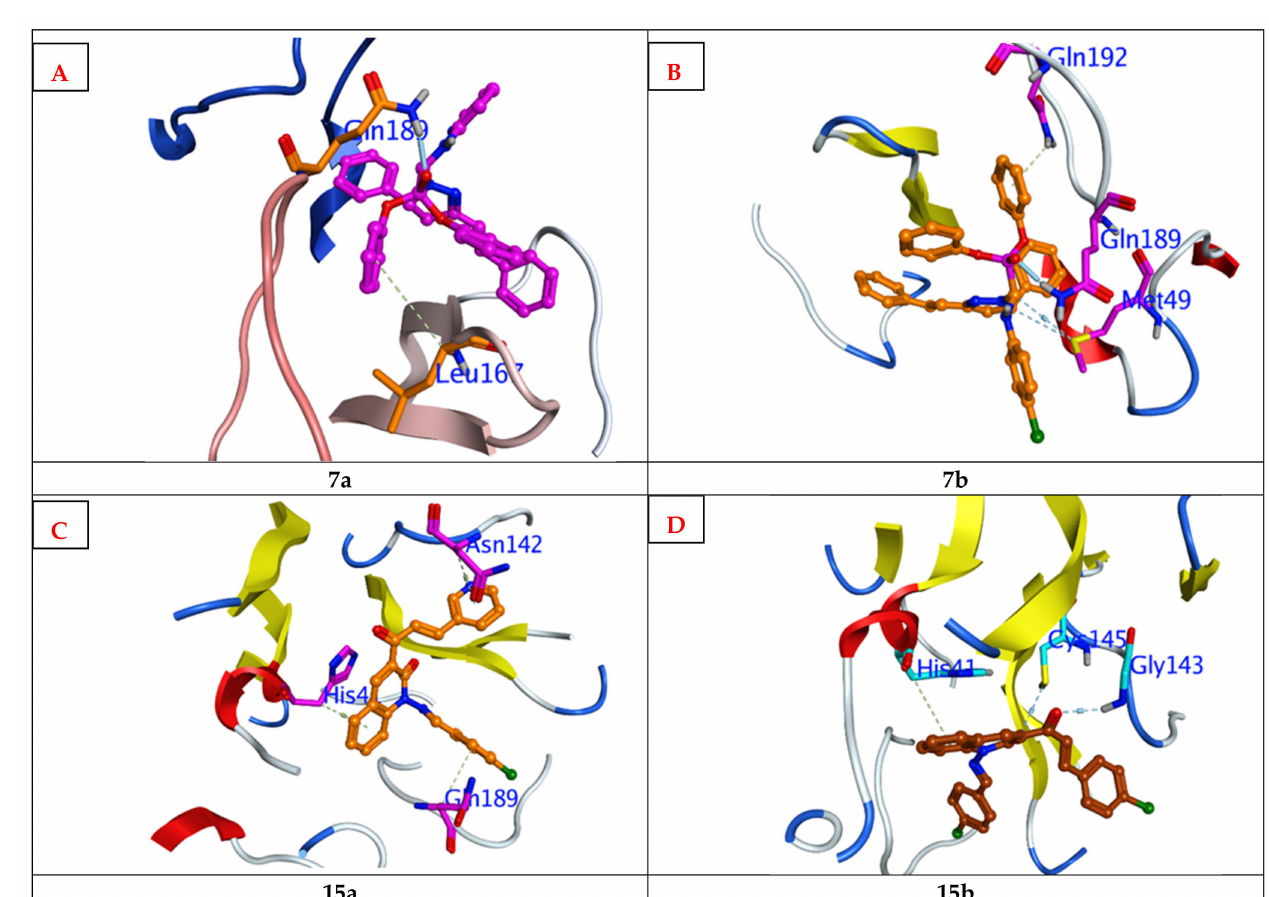
Figure 6. Molecular docking of the active compounds ( A ) for 7a , ( B ) for 7b , ( C ) for 15a , and ( D ) for 15b against Thimidylate synthase protein